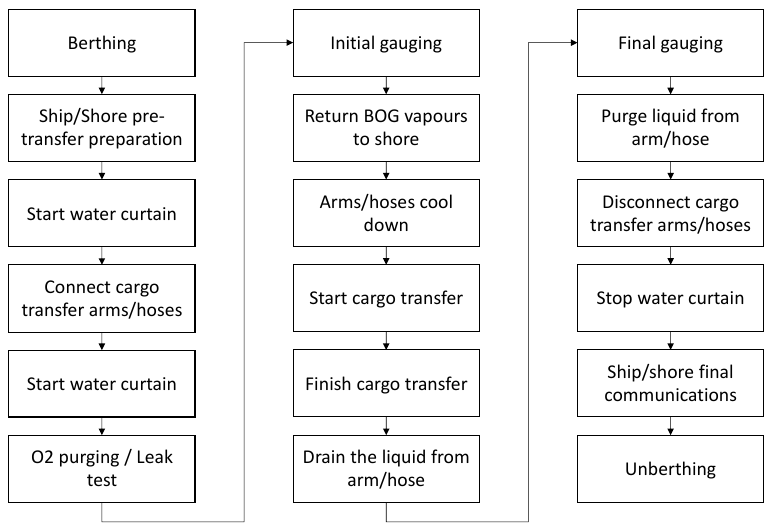
Figure 2. LNG to FSRU transfer processes (authors’ illustration based on relevant technical manuals).